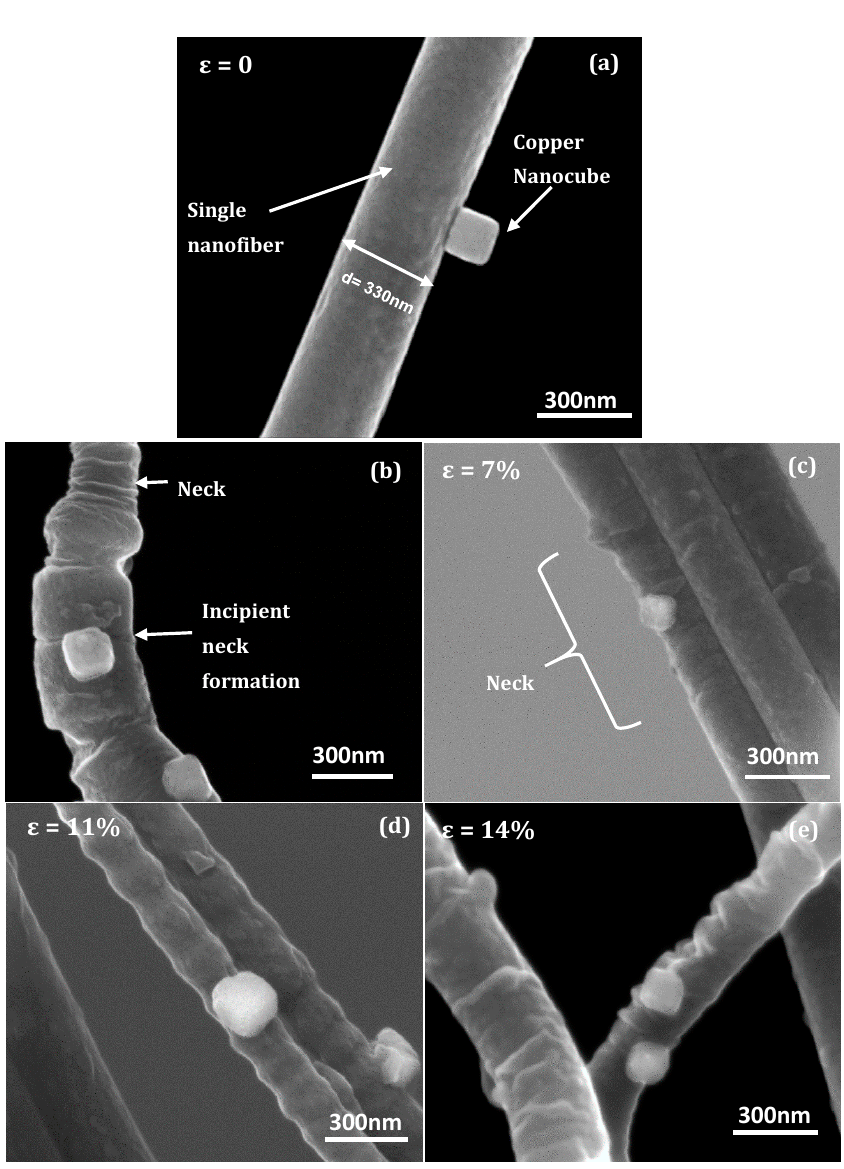
Figure 5. Representative microstructures for ( a ) a copper nanocube on a single nanofiber at zero strain; ( b ) incipient neck region showing nanocubes in vicinity of surface crack; ( c ) nanocube anchored to underlying neck region at ε = 7%; ( d ) adhered nanocubes on neck region at ε = 11%; ( e ) adhered nanocubes on neck region at ε = 14%.